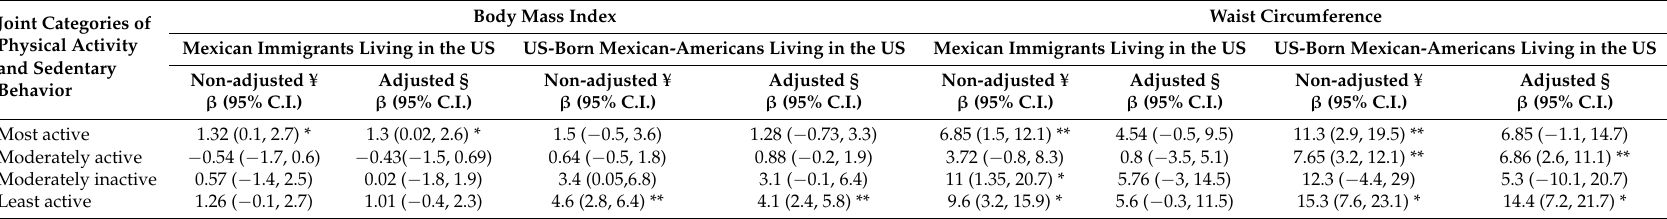
Table 2. Joint associations of physical activity and sedentary behavior on the body mass index and waist circumference of Mexico-born living in Mexico, Mexican immigrants and Mexican-Americans living in the US National Health and Nutrition Databases from the United States and Mexico (NHANES 2011–2012 and ENSANUT